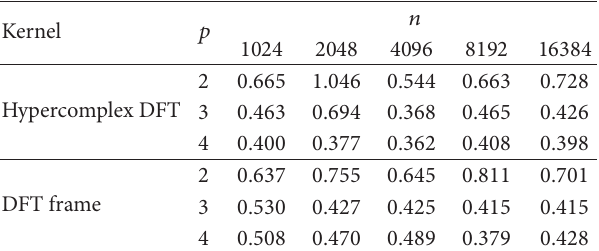
Table 3: Efficiency of Algorithm